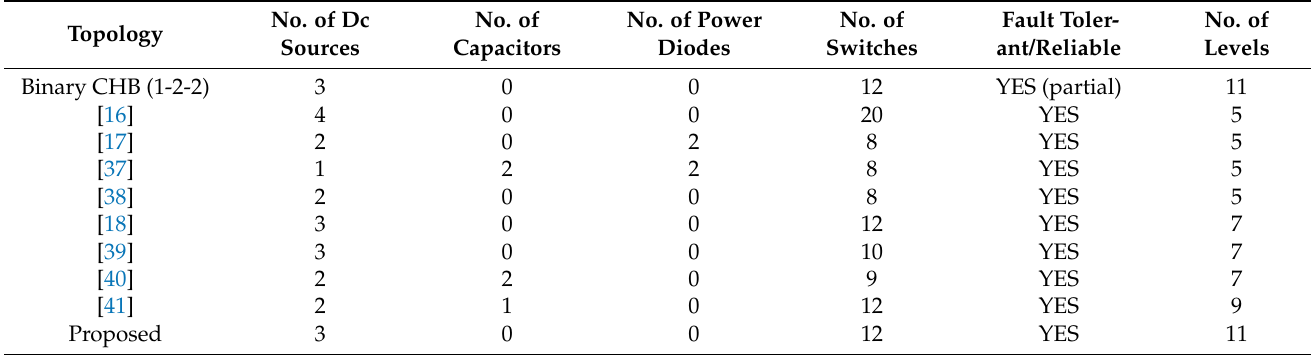
Table 4. Comparative assessment.